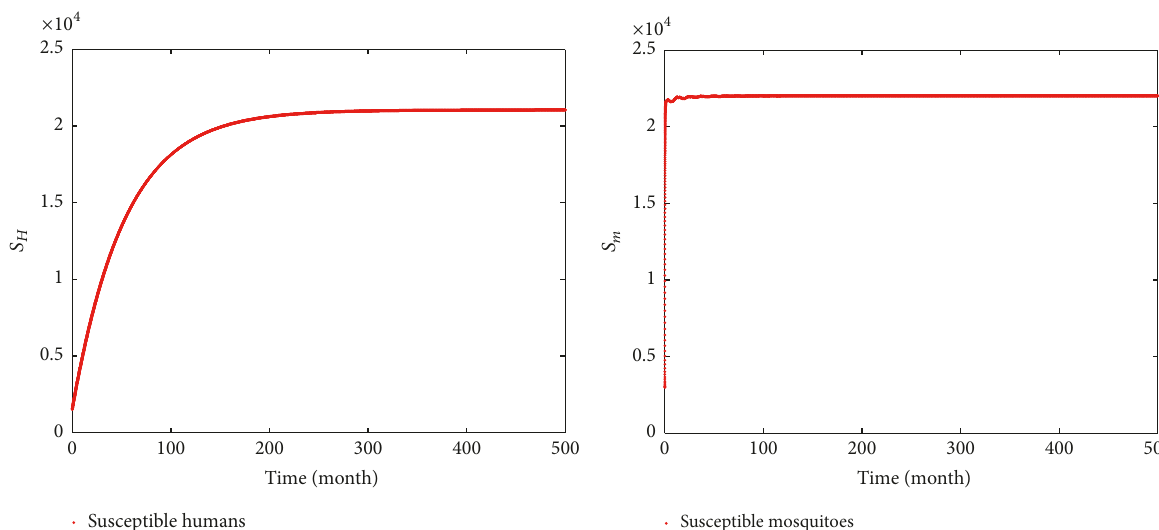
Figure 5: Distribution of susceptible humans and mosquitoes.